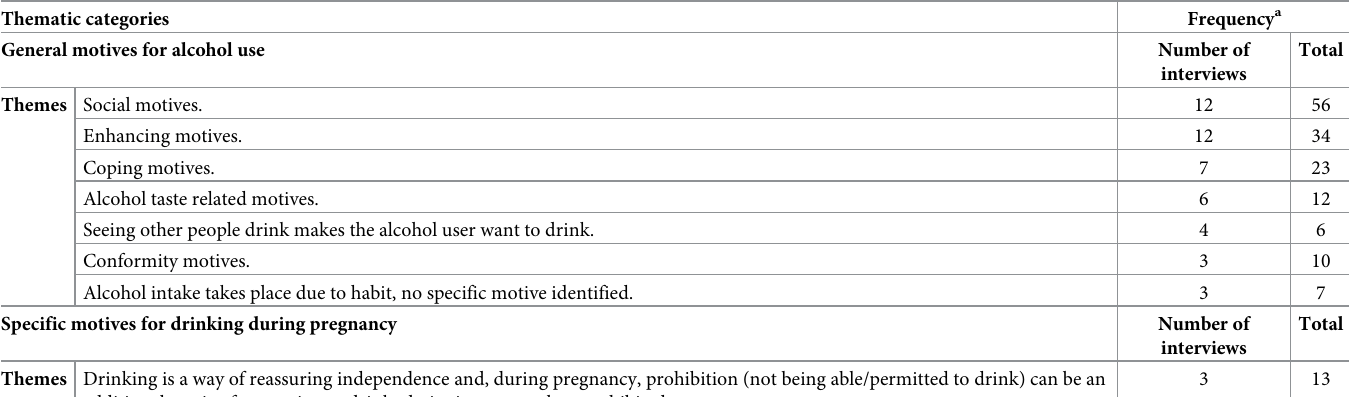
Table 3. Main themes in the different thematic categories and their frequencies. Thematic